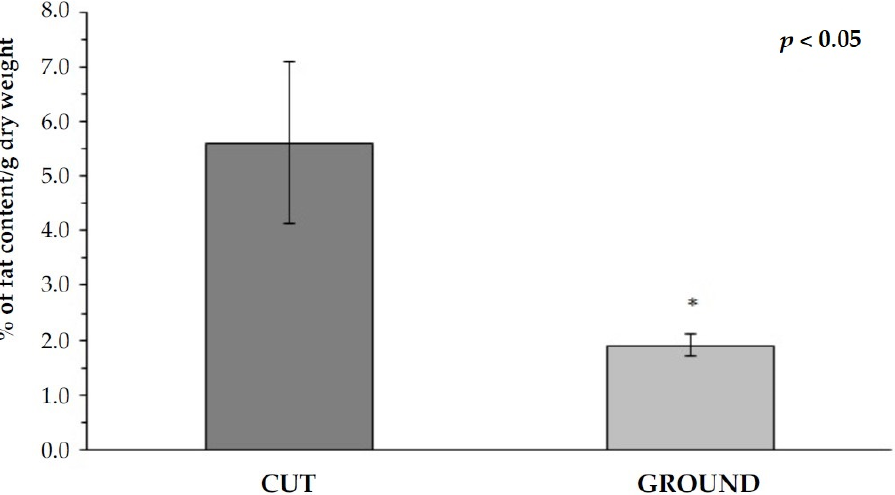
Figure 6. The percentage of total fat depending on the method of grinding the tissue undergoing the decellularization process (MV ± SD, n = 3, * p < 0.05).